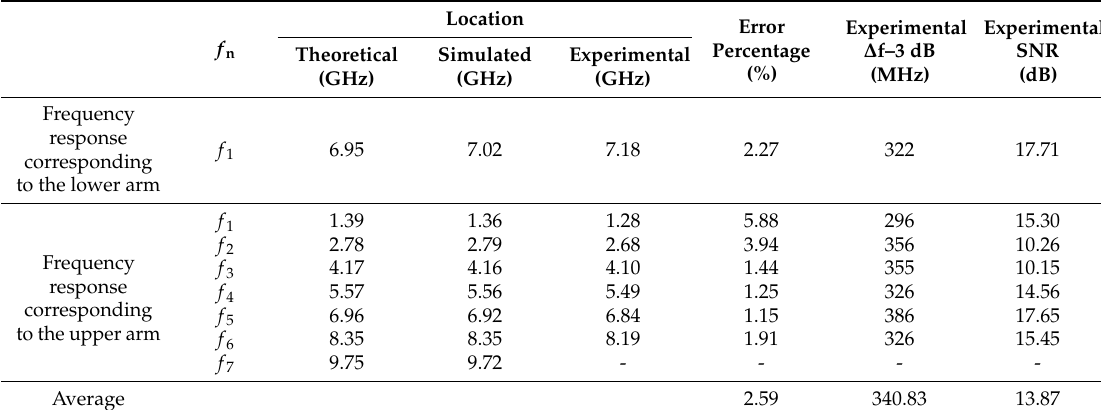
Figure 10. RF spectrum measured at the output of the upper arm. Table 1. Summary of results.